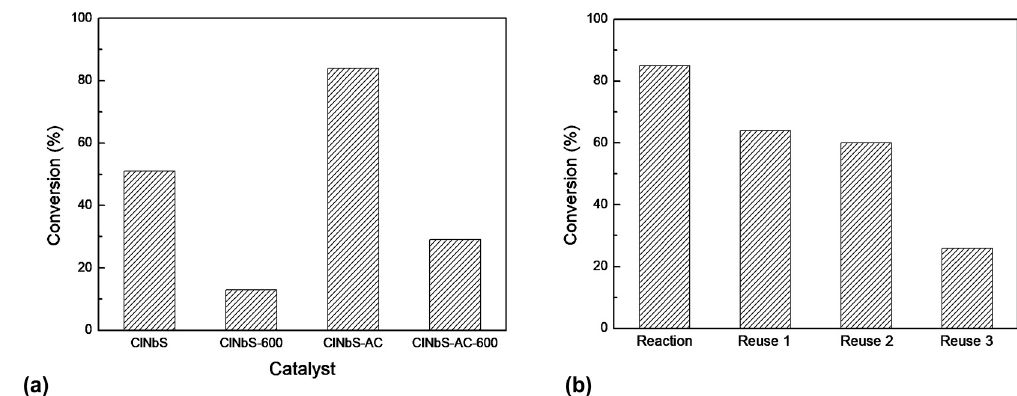
Figure 4. ( a ) Epoxidation reactions using niobium catalysts. Conditions: 25 °C; 60 min; molar ratio (2:1) H 2 O 2 /cyclohexene; 50 mg of catalyst. ( b ) ClNbS-AC catalyst reuse test at 25 °C, 60 min, 50 mg catalyst and H 2 O 2 /cyclohexene molar ratio 2:1.